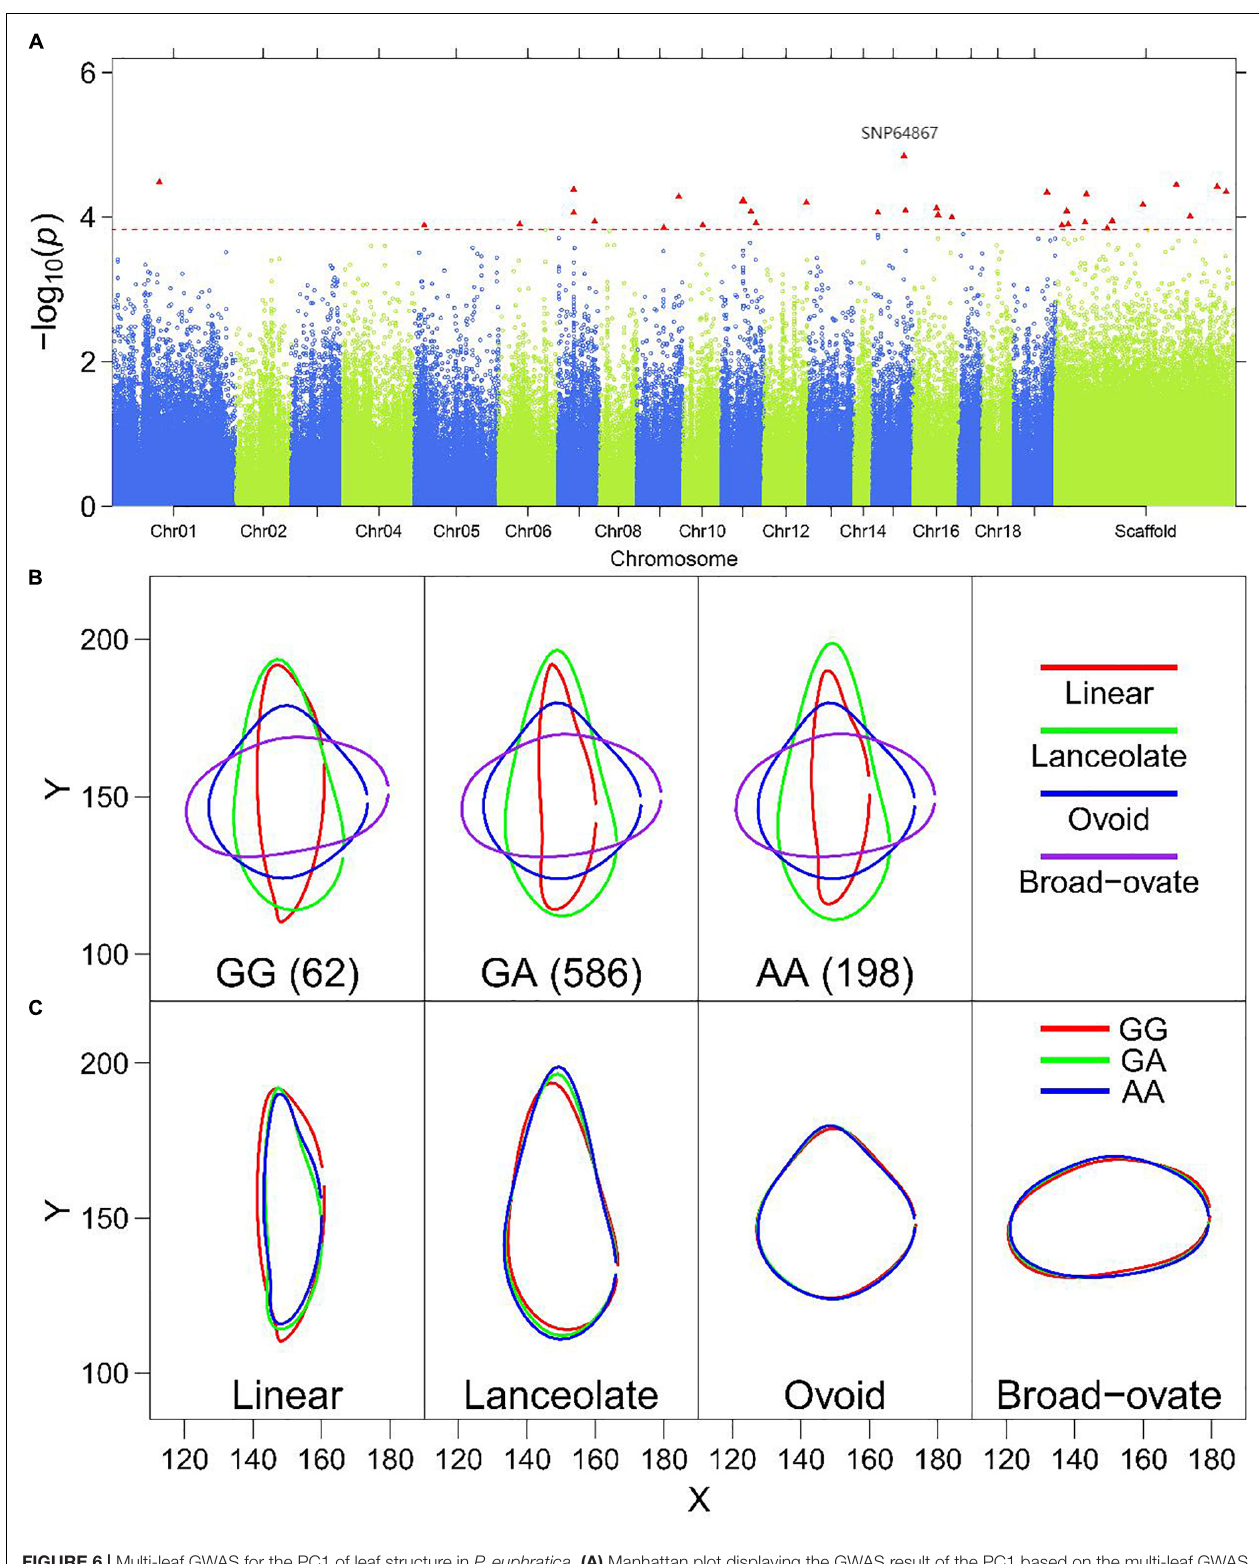
FIGURE 6 | Multi-leaf GWAS for the PC1 of leaf structure in P. euphratica . (A) Manhattan plot displaying the GWAS result of the PC1 based on the multi-leaf GWAS. The significantly associated SNP markers are labeled. (B) Leaf outline of PC1 of heterophylly plotted as a function of genotypes at SNP64867. (C) Visualized variation in the shape of four heterophyllous leaves in P. euphratica at a significant SNP (SNP64867 on scaffold NW_011500277.1).